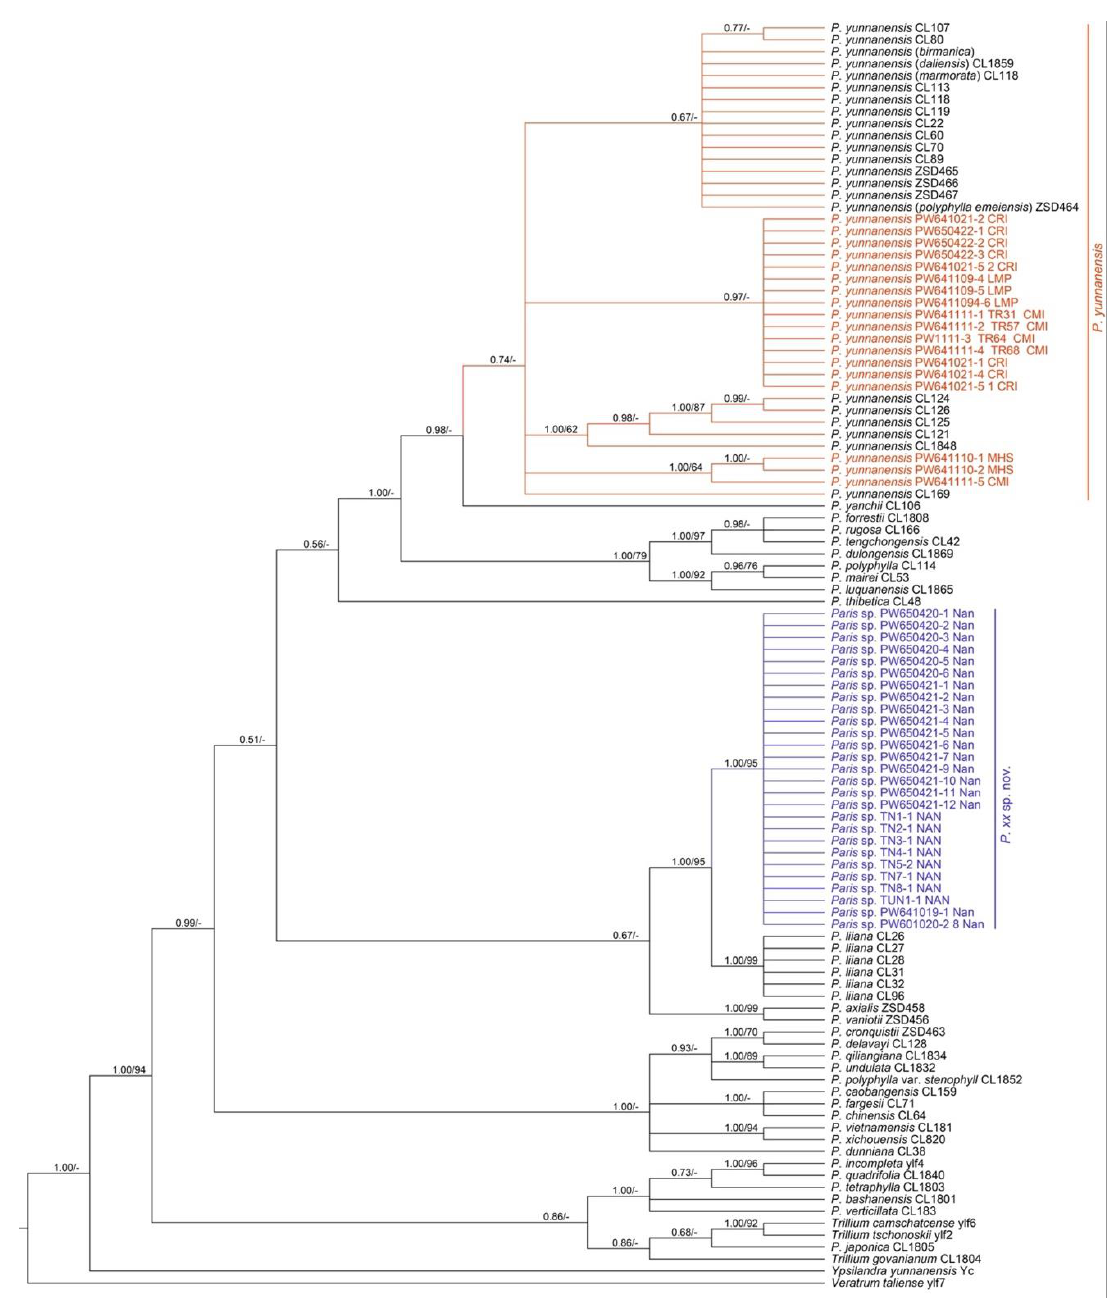
Figure 5. The majority rule consensus tree results from Bayesian inference for the ITS dataset. Numbers above branches indicate posterior probabilities (PP) and bootstrap percentage (BP). Dashes indicate support values of less than 50%. The two species of Paris from Thailand are distinguished by different colors.